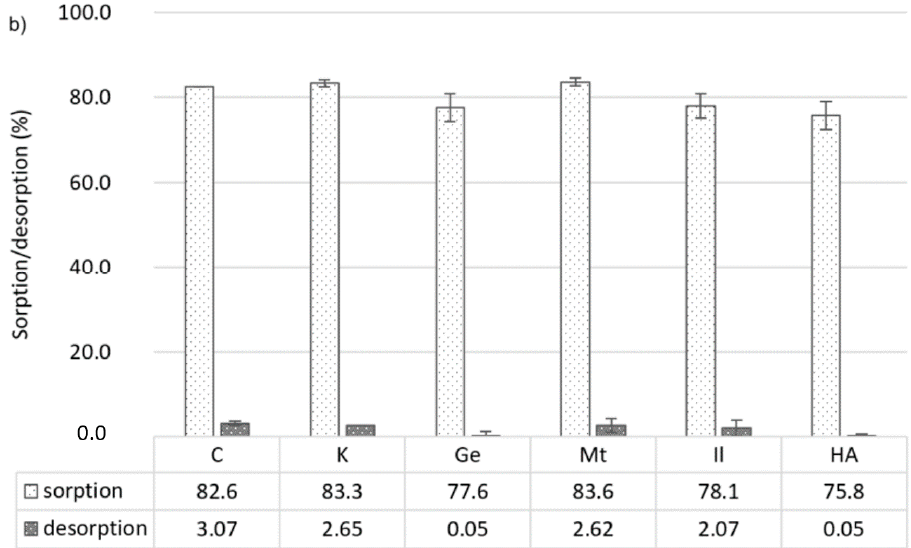
Figure 6. Comparison of sorption and desorption magnitude for metolachlor in ( a ) soil L and ( b ) soil C. Error bars represent standard deviation of triplicate samples.